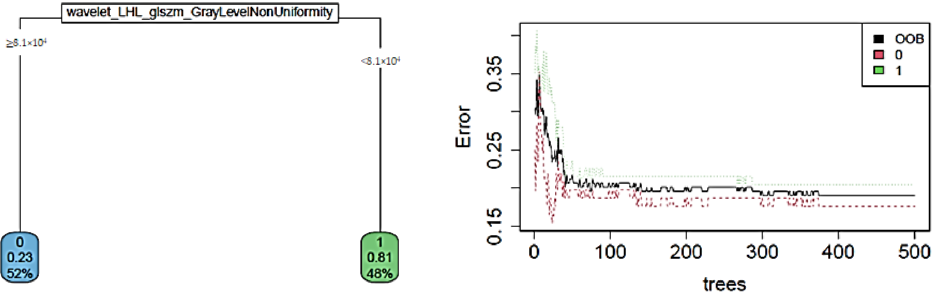
Figure 4. The decision chart and error evolution for the prediction of grading from MLO images. Combinations of only two features, extracted from both CC and MLO views, always showed test accuracy values greater than or equal to 90.00% (Table 5), with the only exception being the HER2 outcome, where the best performance (test accuracy of 89.29%) was obtained with the RF